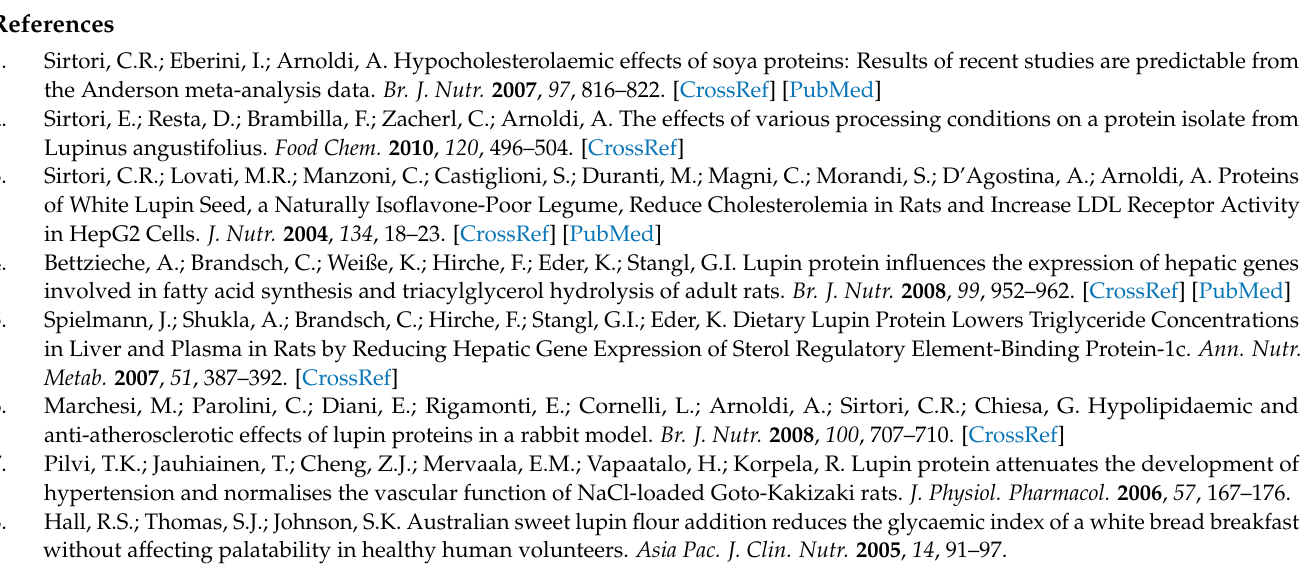
Tables S2–S4, Figure S9: 2D gel map comparison of L. luteus Taper and Dukat cultivars; the corre- sponding identifications are reported in Tables S5 and S6, Figure S10: 2D gel map comparison of L. luteus Taper and Mister cultivars; the corresponding identifications are reported in Tables S7 and S8, Table S1: List of the identified protein spots in Luxor cultivar of Lupinus albus . Spots refer to Figure 3a, Table S2: List of the identified protein spots with comparison between relative abundance of Modica ecotype vs. Luxor cultivar. Spot numbers refer to Figure S8, Table S3: List of identified proteins exclusive to Modica ecotype in comparison with Luxor cv. Spot numbers refer to Figure S8, Table S4: List of identified proteins exclusive to Luxor cv. in comparison with Modica ecotype. Spot numbers refer to Figure S8, Table S5: List of identified proteins exclusive to Taper cv. based on the Dukat vs. Taper cultivar comparison. Spot numbers refer to Figure S9, Table S6: List of identified proteins exclusive to Dukat cv. based on the Dukat vs. Taper cultivar comparison. Spot numbers refer to Figure S9, Table S7: List of identified proteins exclusive to Taper cv. based on the Mister vs. Taper cultivar comparison. Spot numbers refer to Figure S10, Table S8: List of identified proteins exclusive Table S9: List of the identified protein spots in the Sonet cultivar of L. angustifolius . Spots refer to Figure